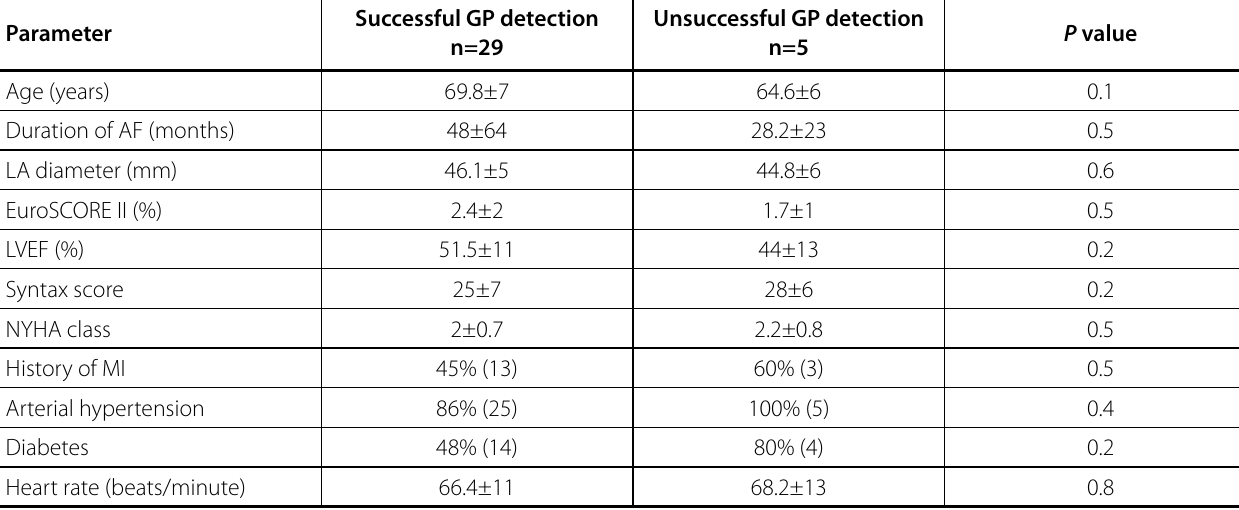
Table 2. Preoperative comparison of patients in whom GP detection was successful versus those in whom it was unsuccessful.